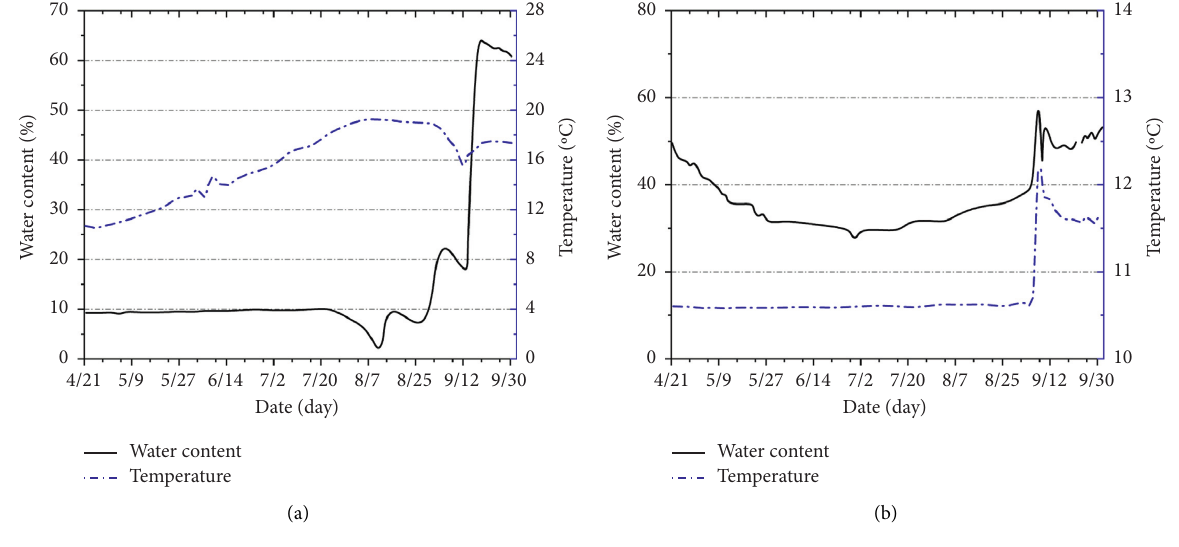
Figure 4: Temperature and moisture curve. (a) At 2m depth. (b) At 7 m depth.